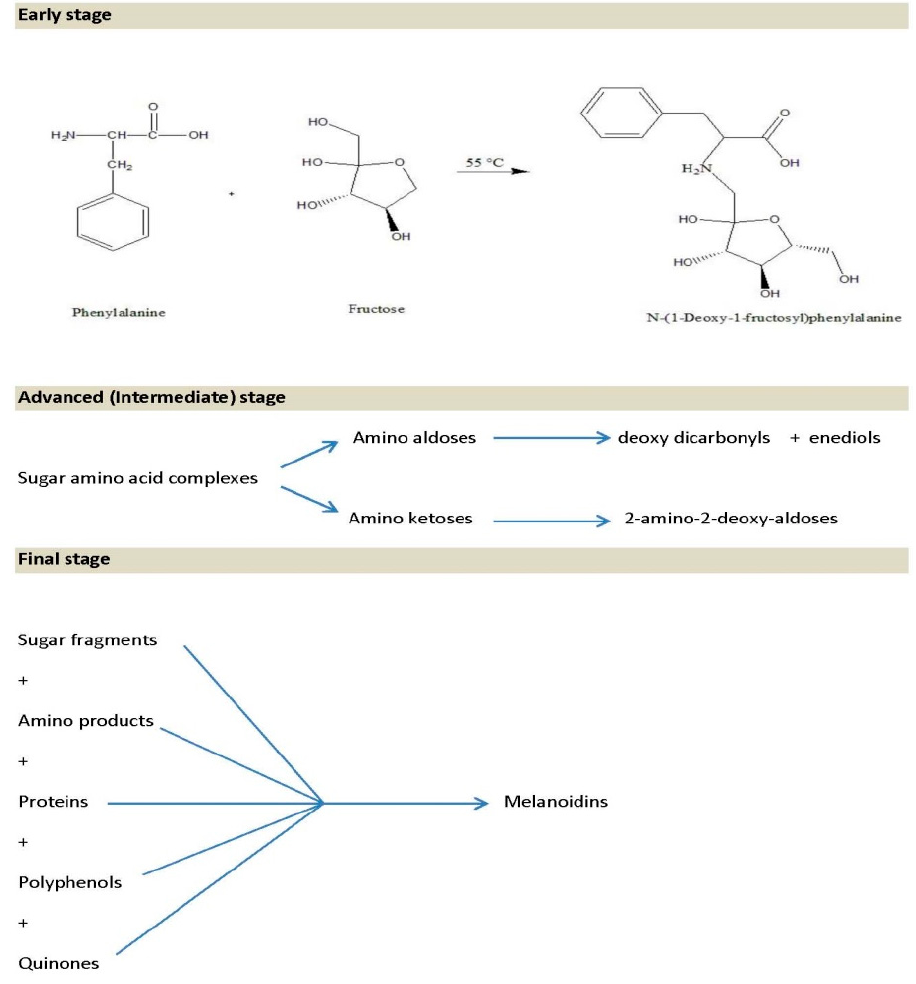
Figure 6. Stages of the Maillard reaction in honey [14,103–106].